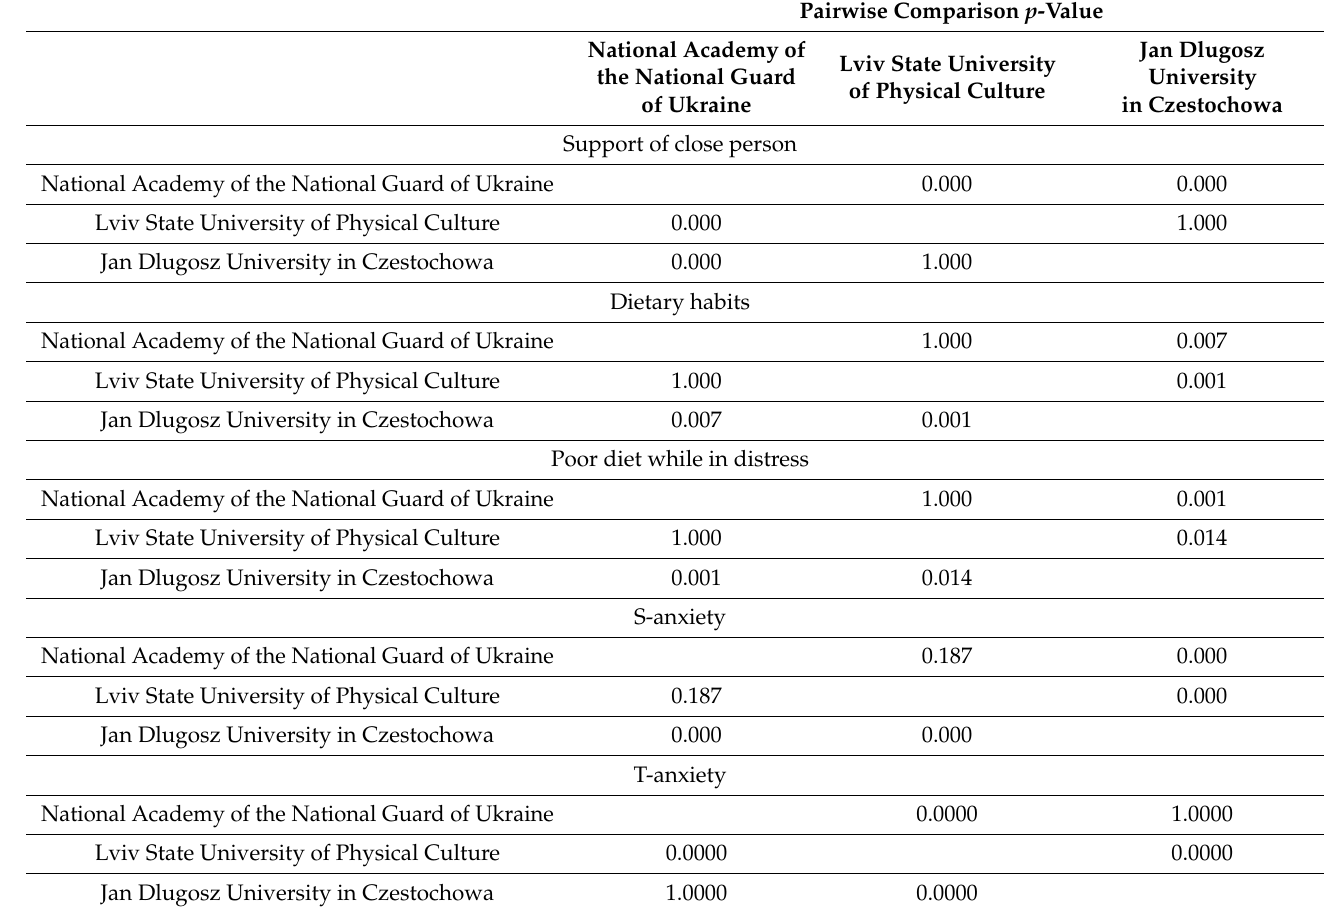
Table 5. Post-hoc pair comparison for three-group analysis of Kruskal–Wallis ANOVA by